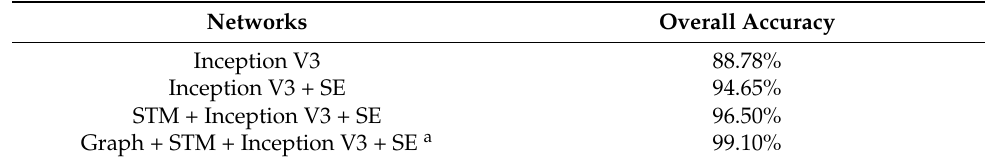
Table 4. The overall accuracy of four models in Dataset 1.